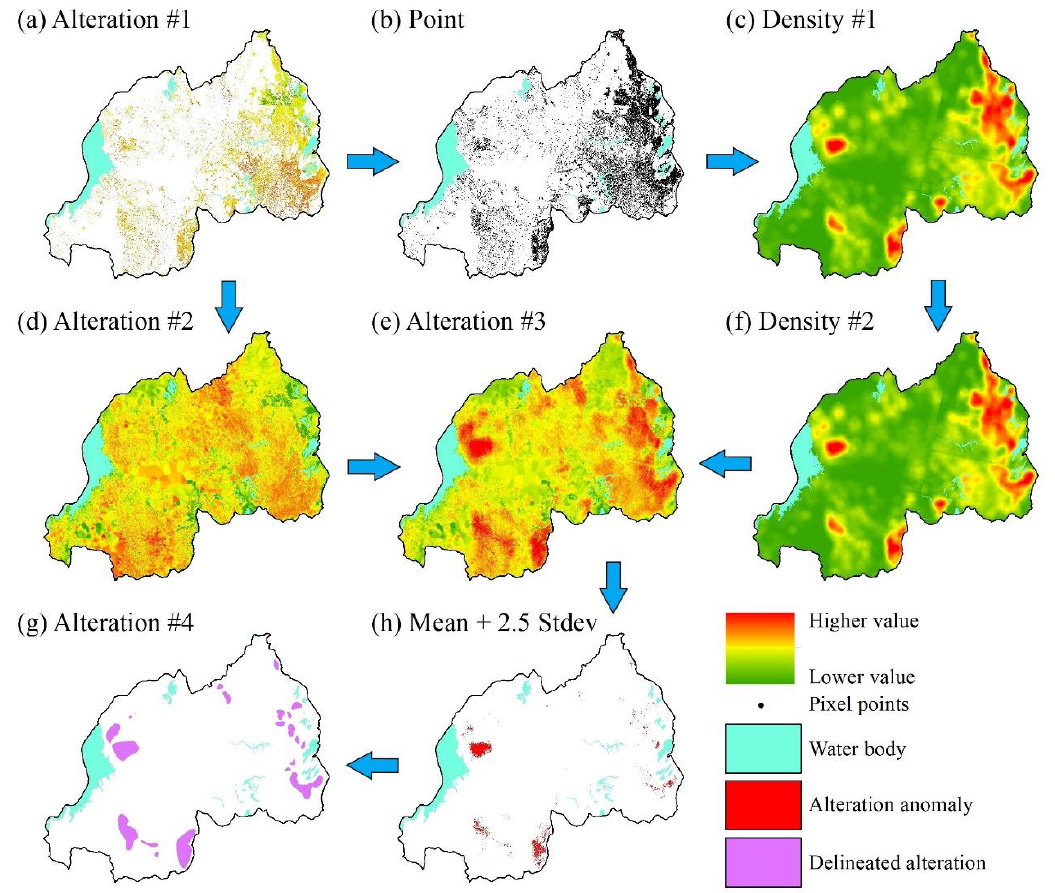
Figure 4. Flowchart of the interpolation – density – delineation (IDD) process. ( a ) Alteration #1 map obtained by DPCA process; ( b ) Point map obtained in the 1st step; ( c ) Density #1 map obtained in the 3rd step; ( d ) Alteration #2 map obtained in the 2nd step; ( e ) Alteration #3 map obtained in the 5th